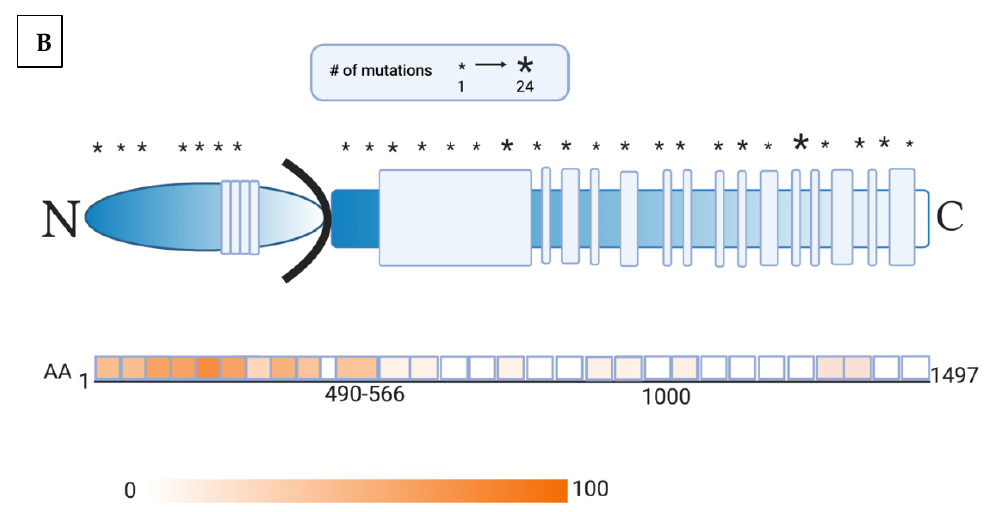
Figure 1. ( A ) Collagen mutation profile and immunogenic domains of epitope reactivity. This